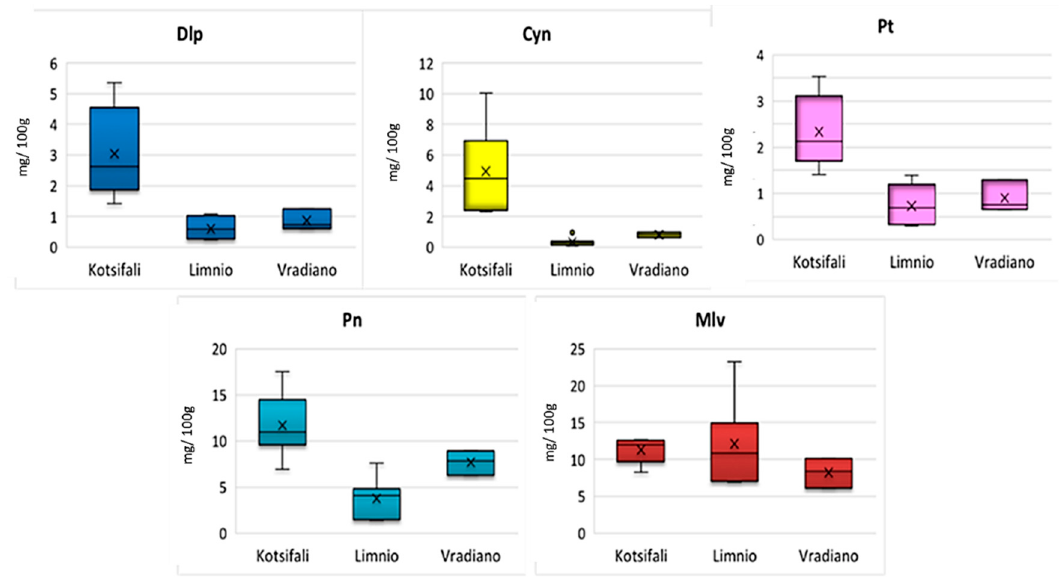
Figure 2. Box and whisker plots for the concentrations of Dlp; Cyn; Pt; Pn; Mlvin red grapes belonging to ‘Kotsifali’, ‘Limnio’, and ‘Vradiano’.